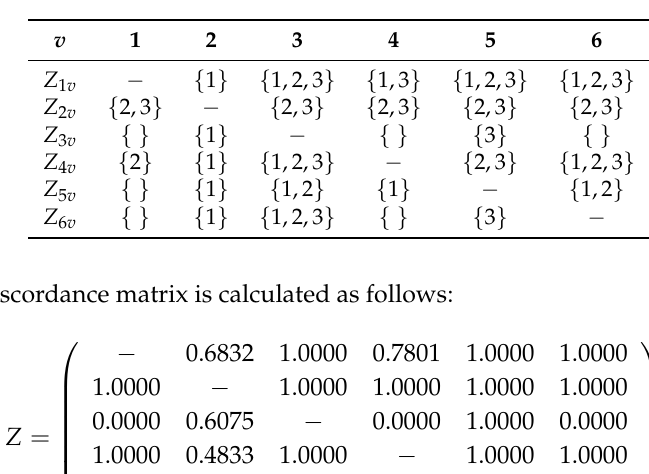
Table 6. Tabular representation of 3HF discordance